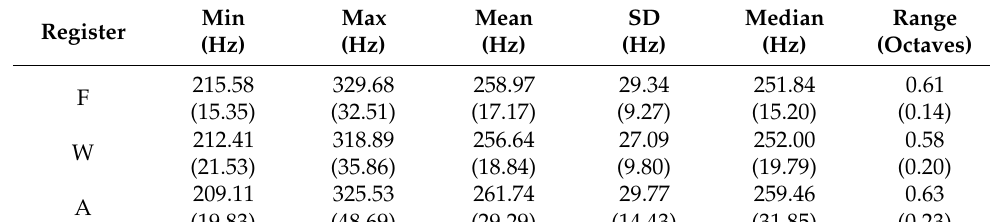
Table 1. Mean (standard deviation) of measures of F0 variation across turns, by register code.